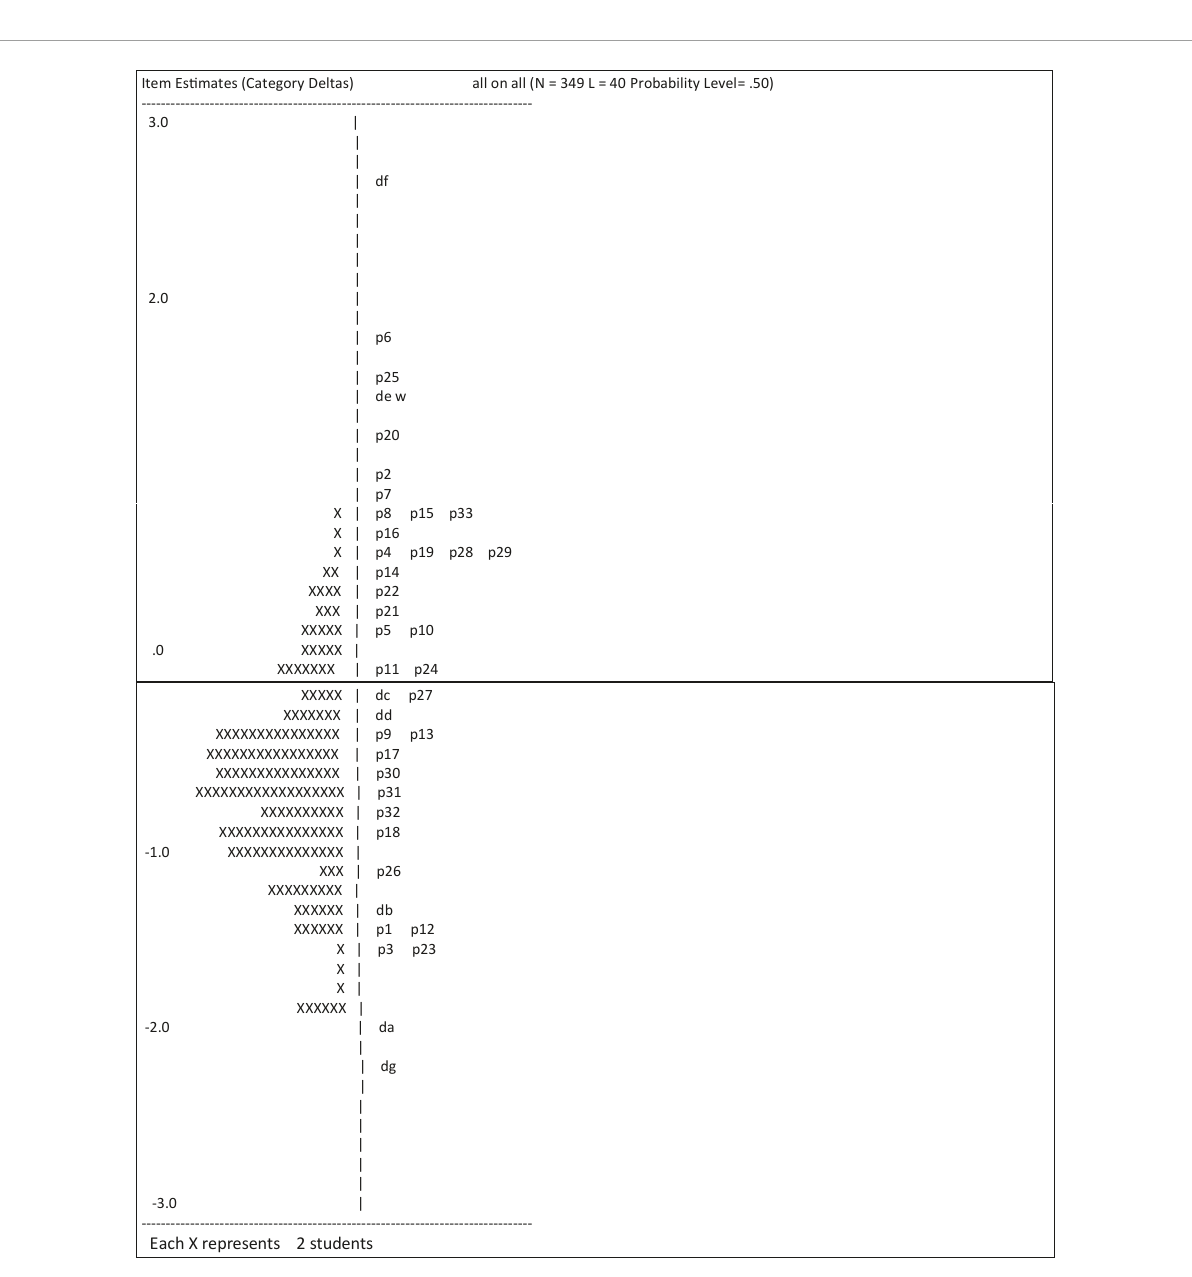
FIGURE1 Rasch analyzed the distribution of the 40 General Ecological Behavior (GEB)-items pointing to a smooth fit- statistics (each X represents 2 students).